Question: In a single sentence, describe what this figure presents.
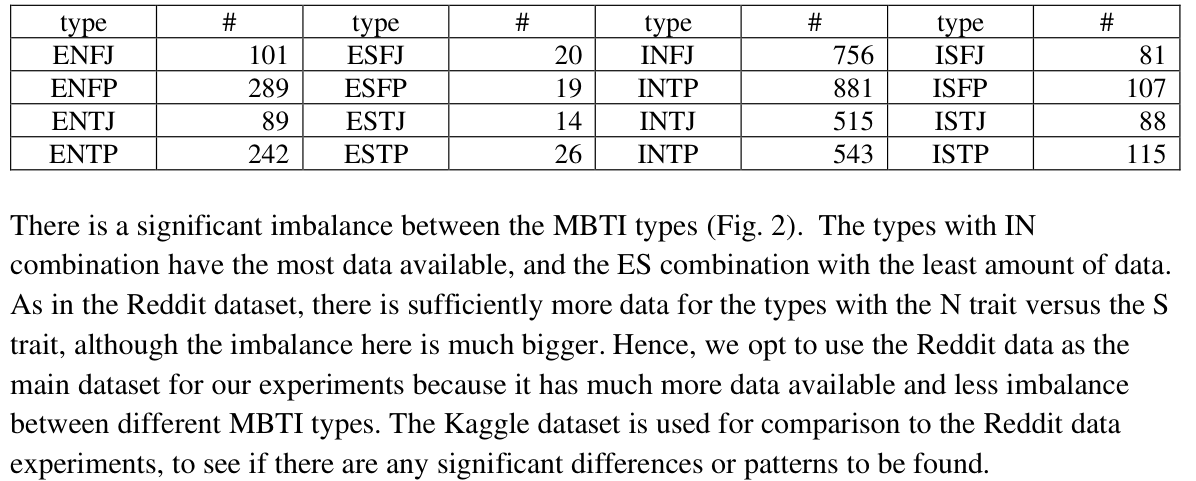
Answer: Distribution of the 16 MBTI types for Kaggle data